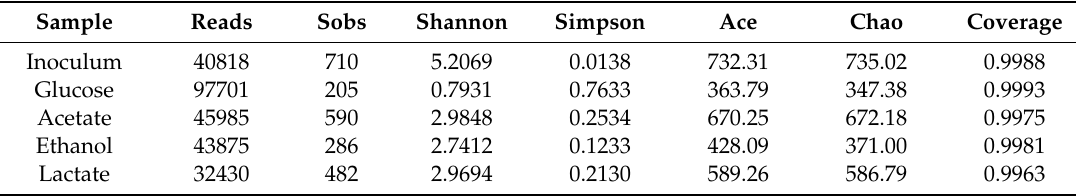
Table 1. The α -diversity of enriched bioelectroactive Table 1. The α-diversity of enriched bioelectroactive biofilms.